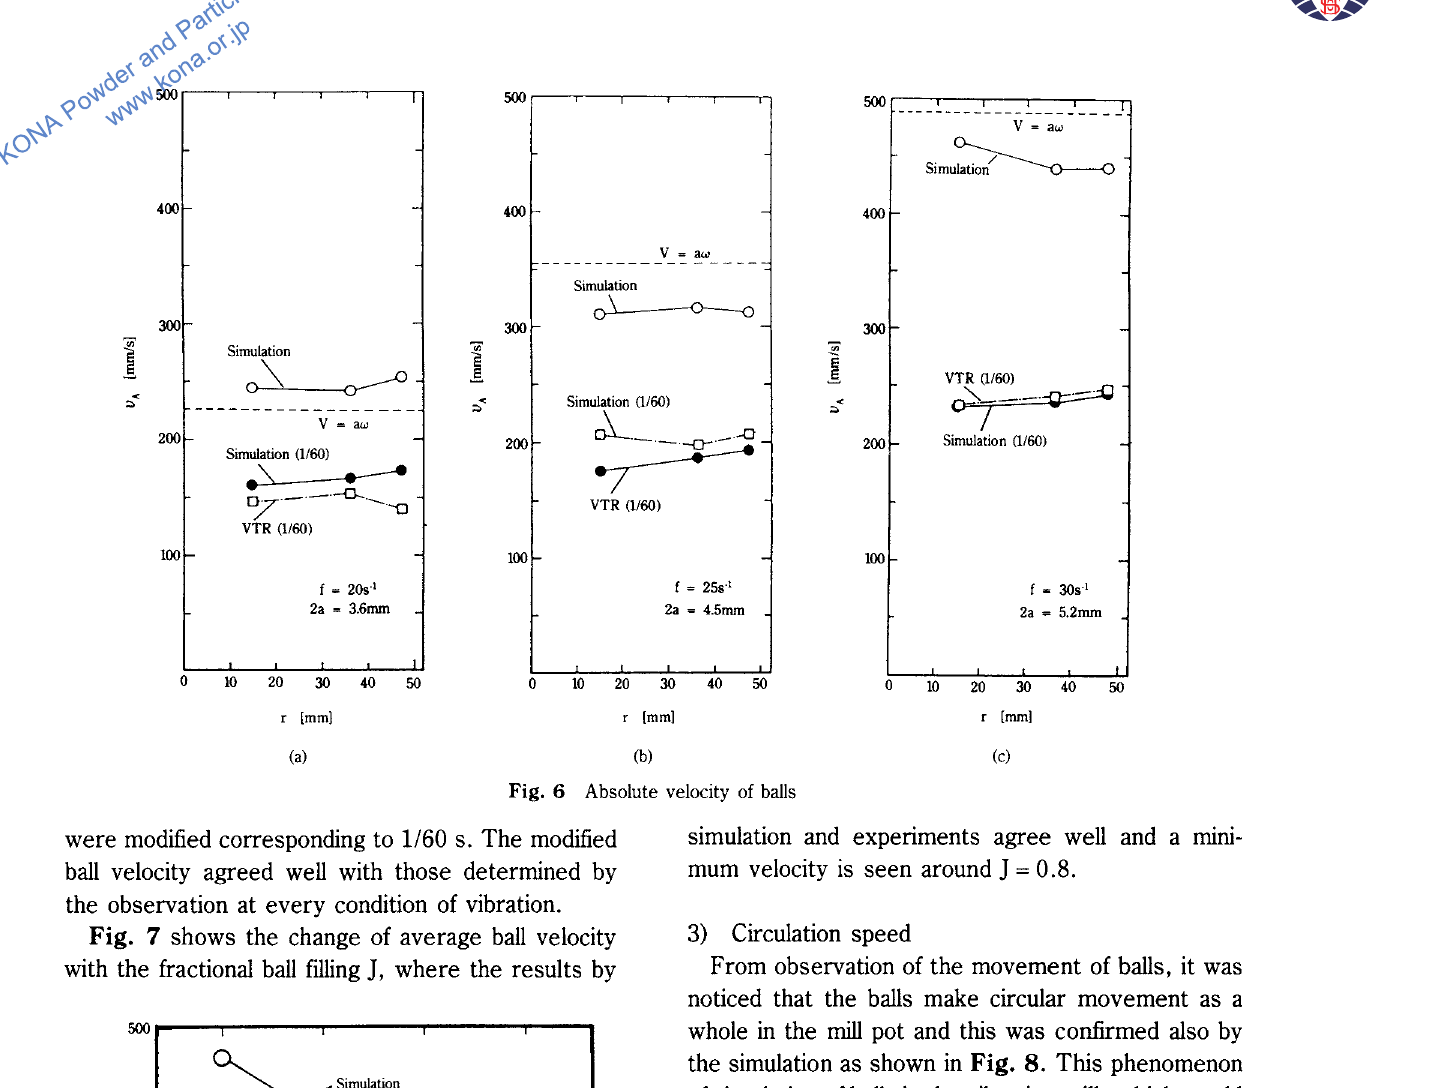
Fig. 6 Absolute velocity of balls